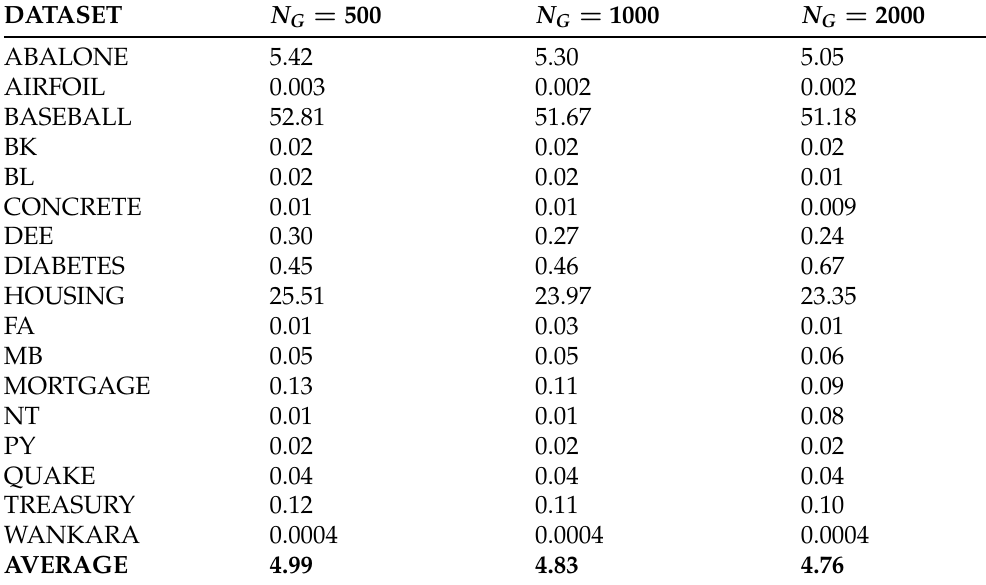
Figure 4. Example of constructed program for the wine dataset. Table 5. Experiments with the number of generations using the proposed method for the regression datasets.